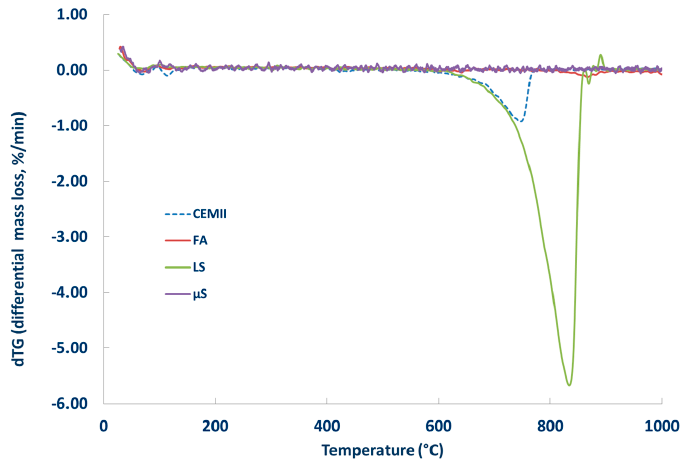
Figure 8. Differential mass loss of microsized constituent materials.